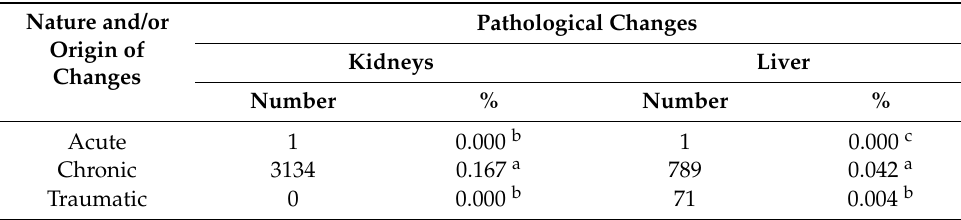
Table 4. The nature and/or origin of pathological changes in the kidneys and liver found in rabbits (n = 1,876,929) after slaughter at the